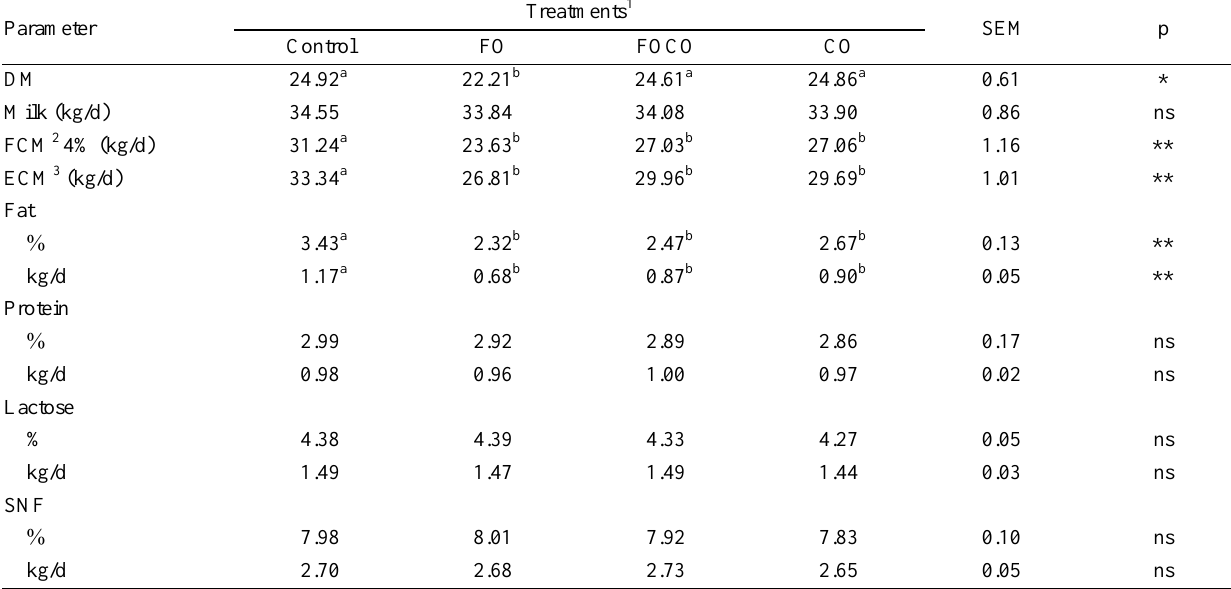
Table 3. Milk yield and composition in early lactating Holsteins fed diets containing fish and canola oil